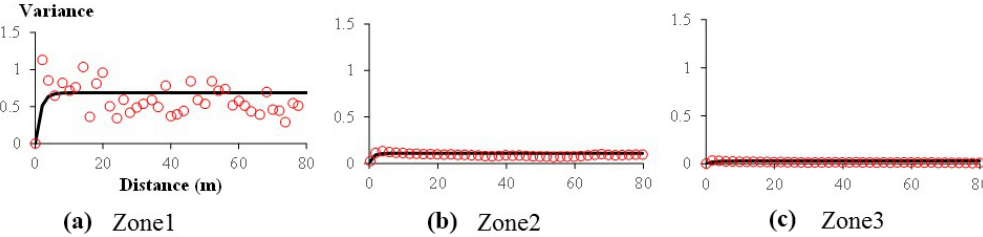
Figure 8. Experimental (circle symbol) and model (solid line) composited semivariogram along the vertical direction for the three zones.